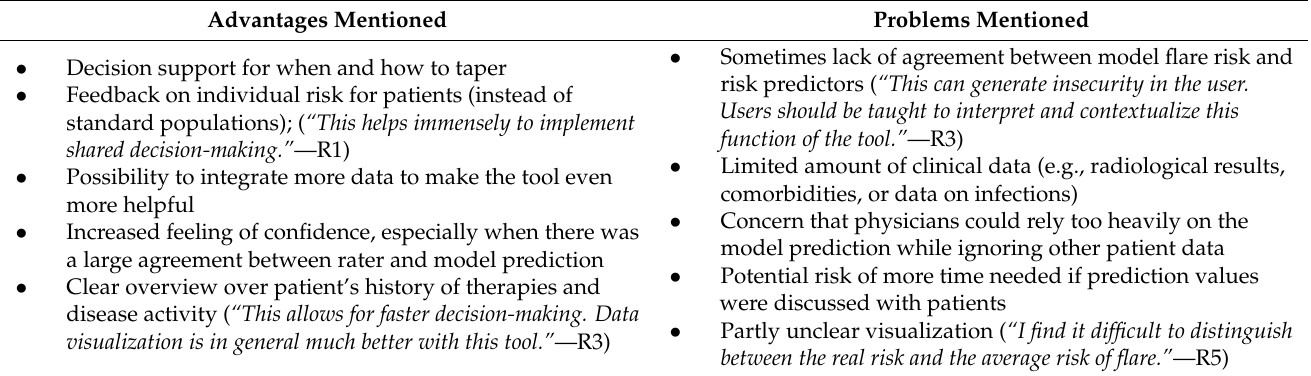
Table 5. Perceived RCM advantages and